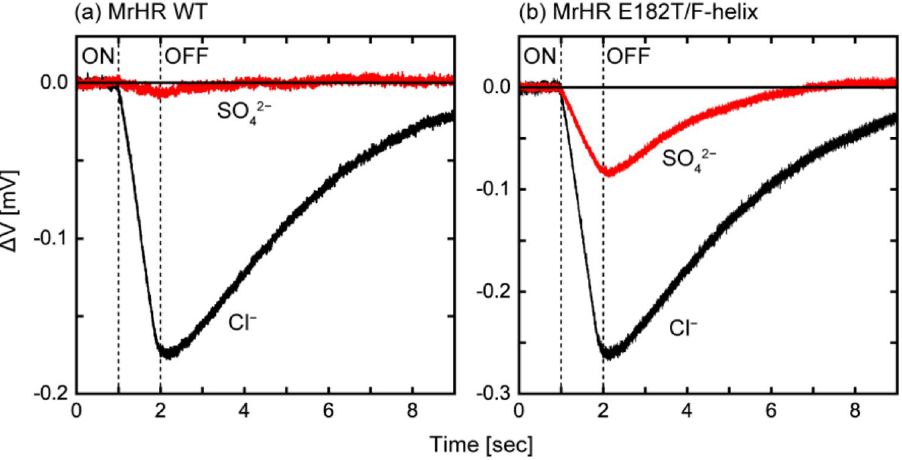
Figure 4. Anion pump activities detected by ITO electrode. The schematic illustration of the electrochemical cell is shown in Supplementary Fig. S4. The light-induced pH differences between the E. coli suspensions and the reference salt solutions were detected as the voltage difference between two ITO electrodes. Two time-courses of the voltage differences in the presence of 0.2 M NaCl (black line) and 0.2 M Na 2 SO 4 (red line) were plotted for wild-type MrHR ( a ) and the E182T/F-helix mutant ( b ), respectively. All solutions also contained 10 μM CCCP. The vertical lines indicate the timing of illumination. The negative deflected change in the voltage difference corresponds to the pH